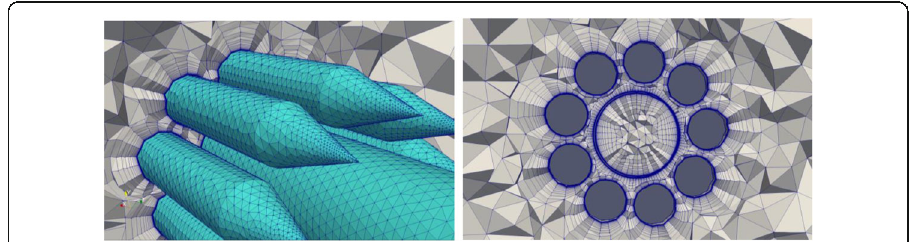
Fig. 8 Cut-out views of the hybrid mesh of the rocket